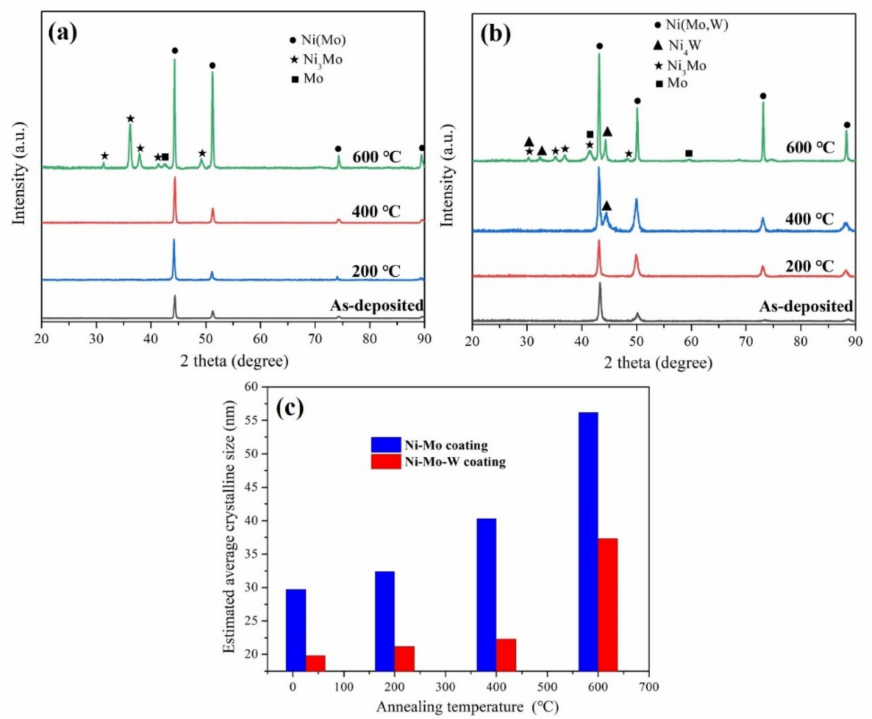
Figure 1. X-ray diffraction patterns of as-deposited and annealed coatings in the temperature range from 200 to 600 ◦ C: ( a ) Ni-Mo coatings; ( b ) Ni-Mo-W coatings, and ( c ) Estimated average crystalline size using Scherrer equation from XRD results.